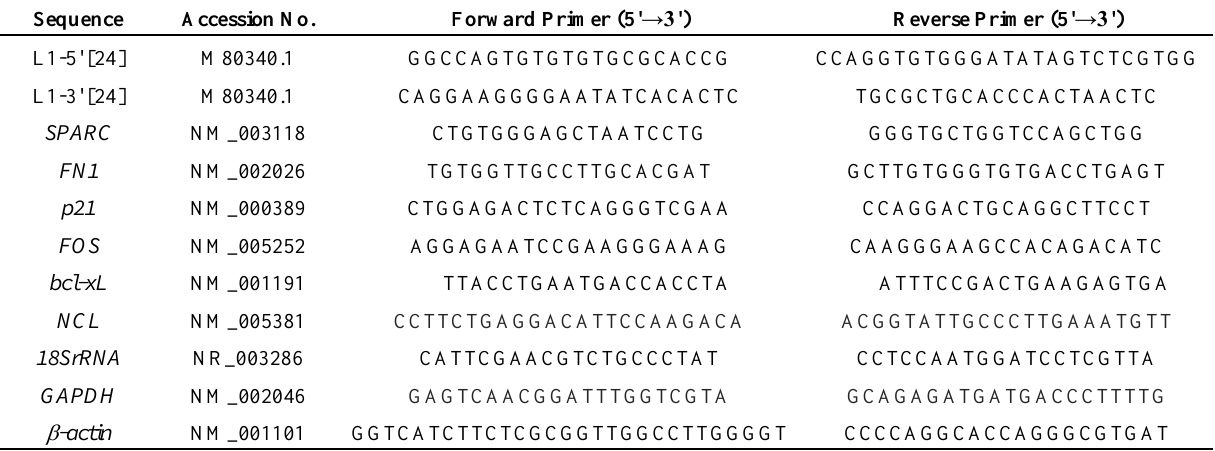
Table 1. Primers used for Quantitative Real-Time Polymerase Chain Reaction